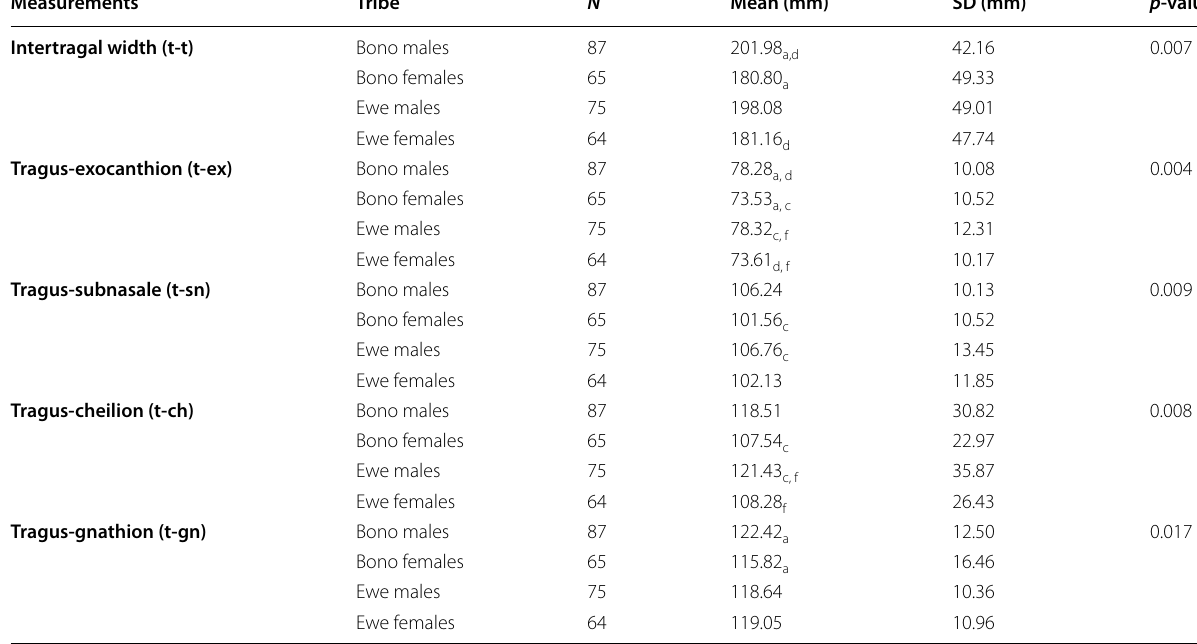
N number of participants, SD standard deviation, mm millimetre, t-t tragus to tragus, t-ex tragus to exocanthion, t-sn tragus to subnasale, t-ch tragus to cheilion, t - gn tragus to gnathion. a, c, d, f identical subscript letters have differences existing between the mean values of two tribes by means of a post hoc test (the p values are = only the result of the ANOVA and not the post hoc test). Statistical significance level at p < 0.05